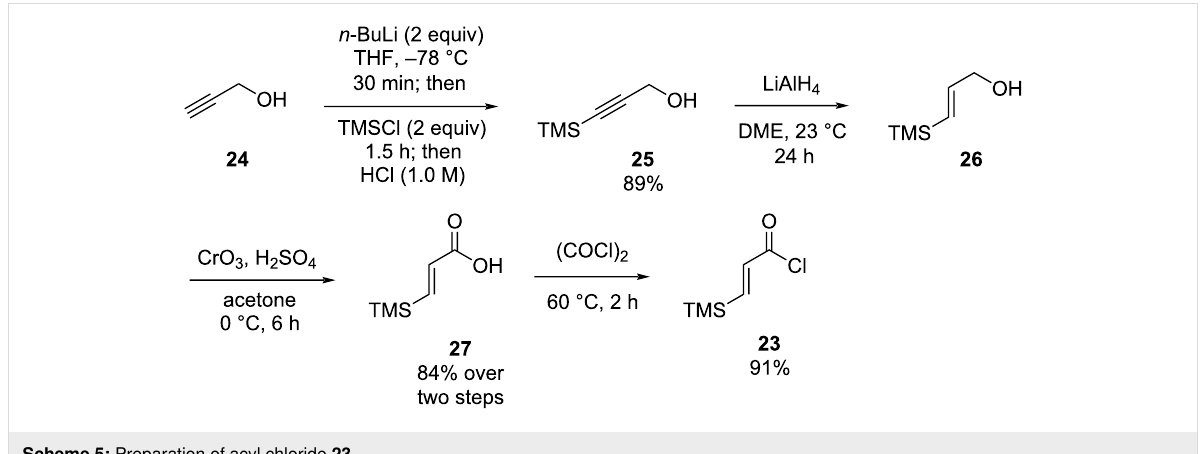
Scheme 5: Preparation of acyl chloride 23